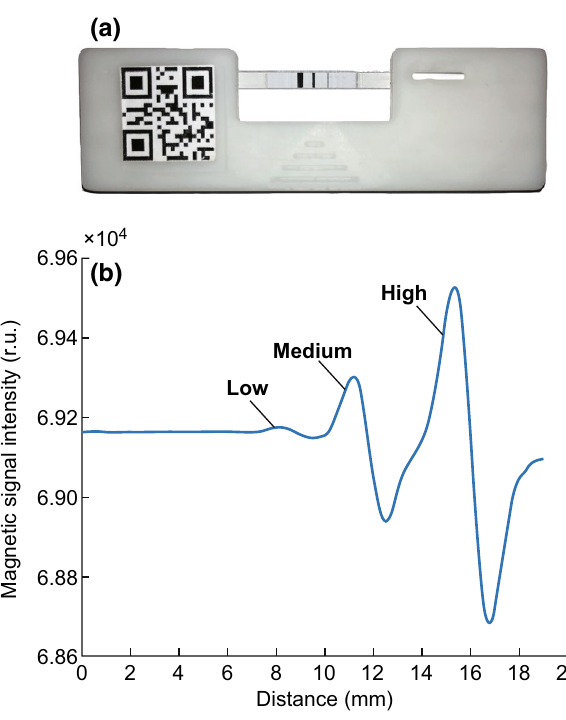
Fig. 3 a Validation card with ICTS cartridge and QR code. b Wave- form of validation card, comprising three levels of magnetic intensity: low, medium, and